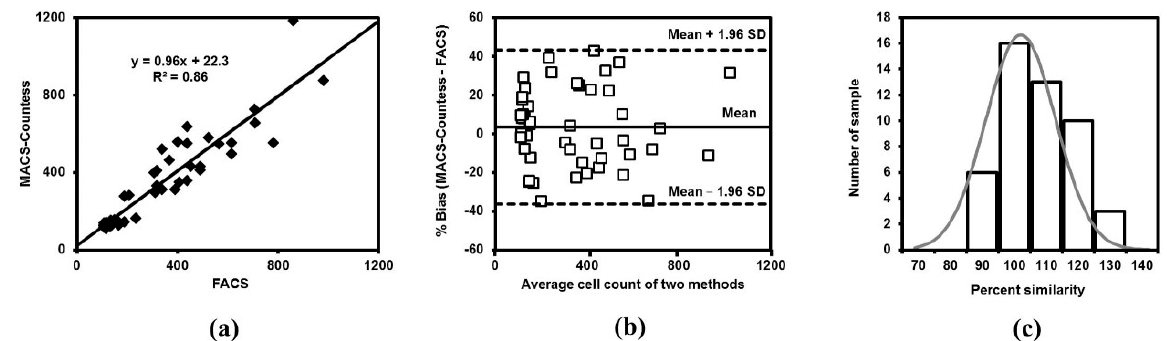
Figure 5. CD4 + T cell counts by the deduced MACS-Countess and FACS methods. ( a ) Deduced MACS-Countess ( x axis) correlates with FACS ( y axis) at R 2 = 0.86. ( b ) Bland–Altman plot with a mean bias of 3.5%, LoA ranging from − 36.4% (Mean bias − 1.96 SD) to 43.3% (Mean bias +1.96 SD). ( c ) Percentage similarity with MPS of 102.9% and CV of 10.6%.